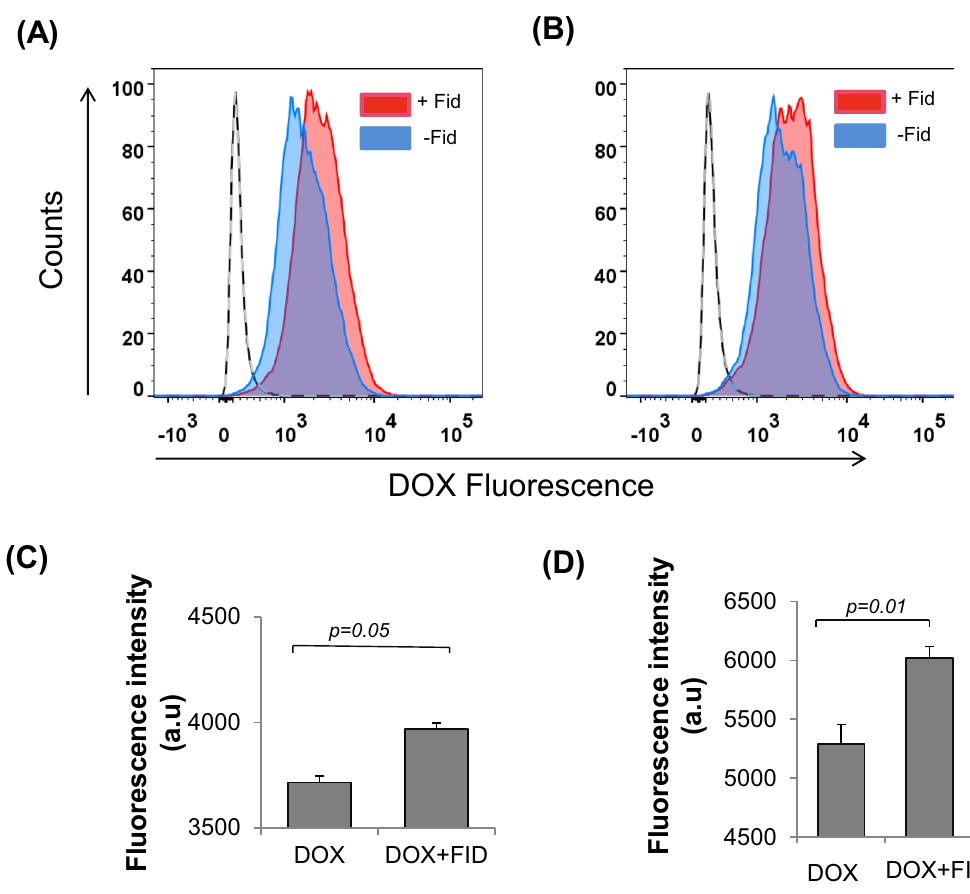
Figure 2. DOX accumulation in colon cancer cells: Flow cytometric analysis showing DOX fluorescence in ( A ) HT-29 and ( B ) SW480 colon cancer cells treated with DOX (1 µ M) in the absence or presence of fidarestat (30 μ M) for 24 h. Red filled histogram is DOX in combination with fidarestat and blue filled is DOX alone. Unfilled histogram with a solid line is untreated control and unfilled histogram with dashed line is fidarestat only treated (n = 3). Bar graph showing DOX (2 μ M) fluorescence in ( C ) HT-29 and ( D ) SW480 cells treated alone or in combination with fidarestat (30 μ M) for 6 h and analyzed by fluorescence spectrophotometry. Values are Mean ± SD (n = 3). Individual p values are mentioned in the